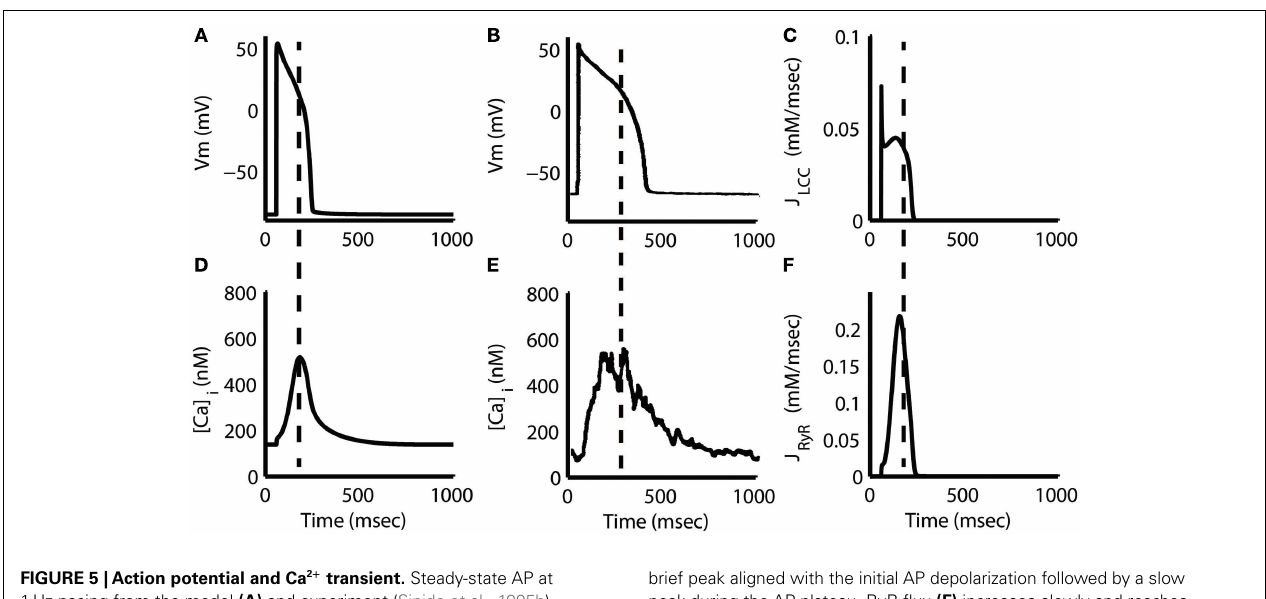
FIGURE 5 |Action potential and Ca 2 + transient. Steady-state AP at 1Hz pacing from the model (A) and experiment (Sipido et al., 1995b) (B) along with the corresponding Ca 2 + transients (D,E) . Note that the peak of the model transient is aligned with the middle of the AP plateau phase (dashed line), approximately 127ms after stimulus. Experimental data in (E) show a similar delay in the Ca 2 + transient peak of approximately 190ms. L-type Ca 2 + flux (J LCC ) (C) shows a large, but